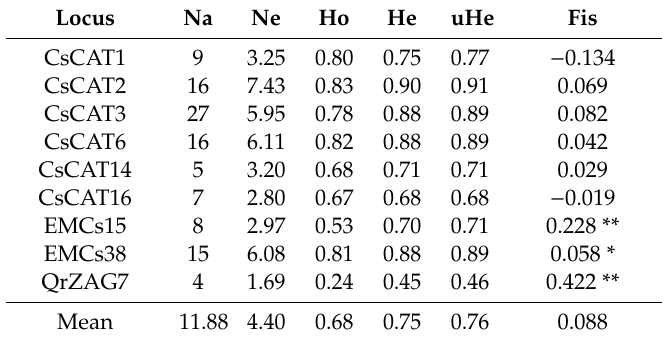
Table 2. Genetic diversity indices of the nine genomic microsatellites (SSRs) used in this study. Locus Na Ne Ho